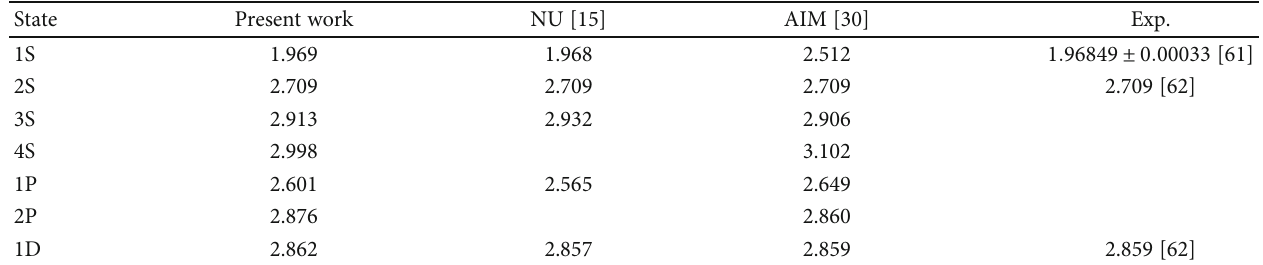
Table 4: Mass spectra of charmed-strange ð cs Þ meson in GeV ð m State Present work